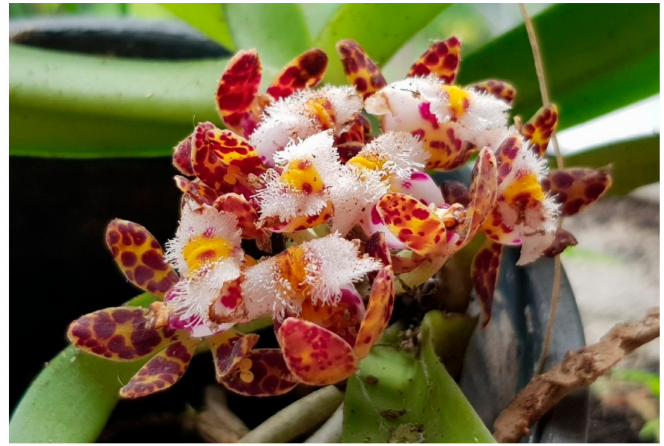
Figure 1. Gastrochilus bellinus (Rchb.f.)